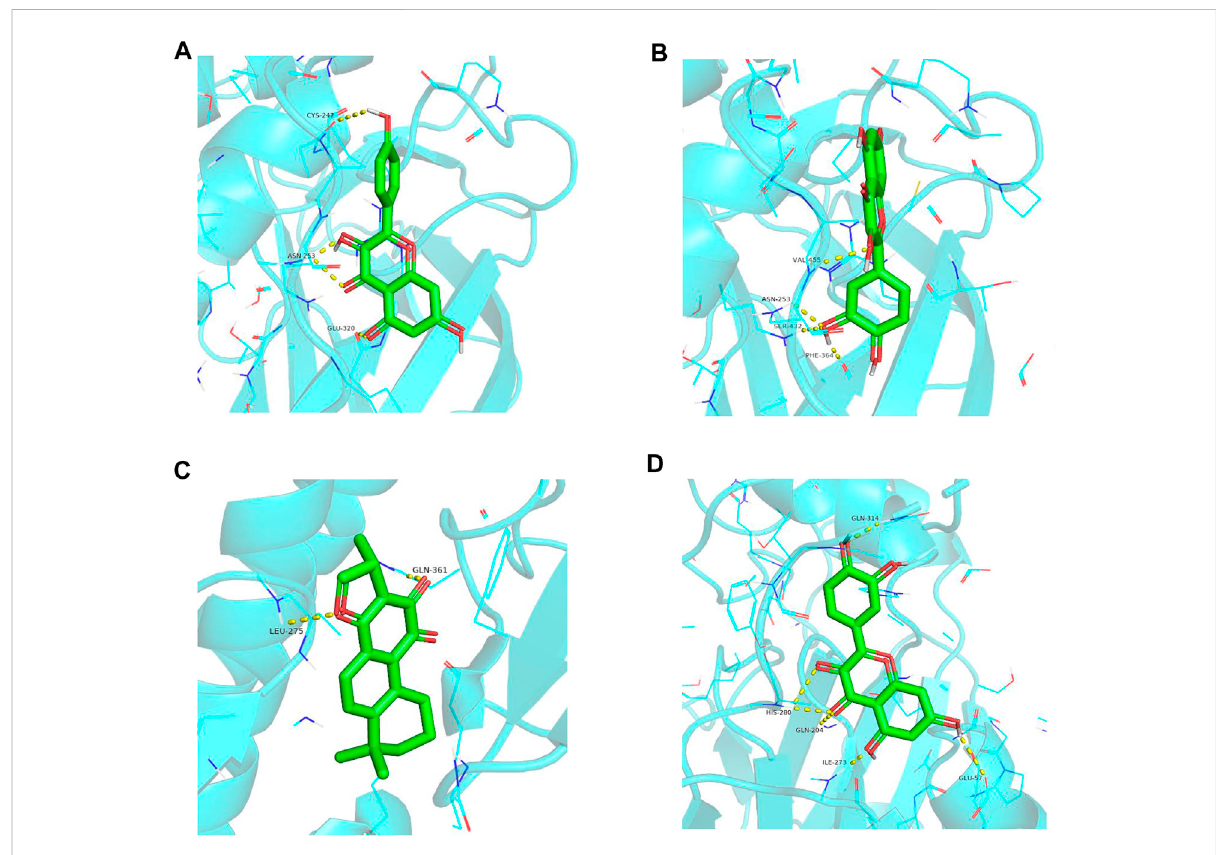
FIGURE 9 Partial diagram of molecular docking. (A) STAT1 – kaempferol; (B) STAT1 – quercetin; (C) STAT3 – crytotanshinone; and (D) HIF1A –